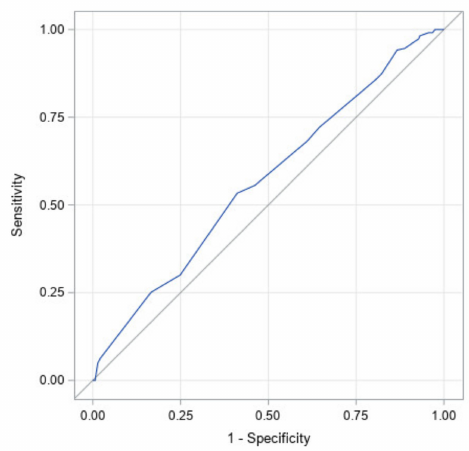
Figure 5. ROC curve for initial age only. The area under the curve is 0.57 (statistically significant with p = 0.002).